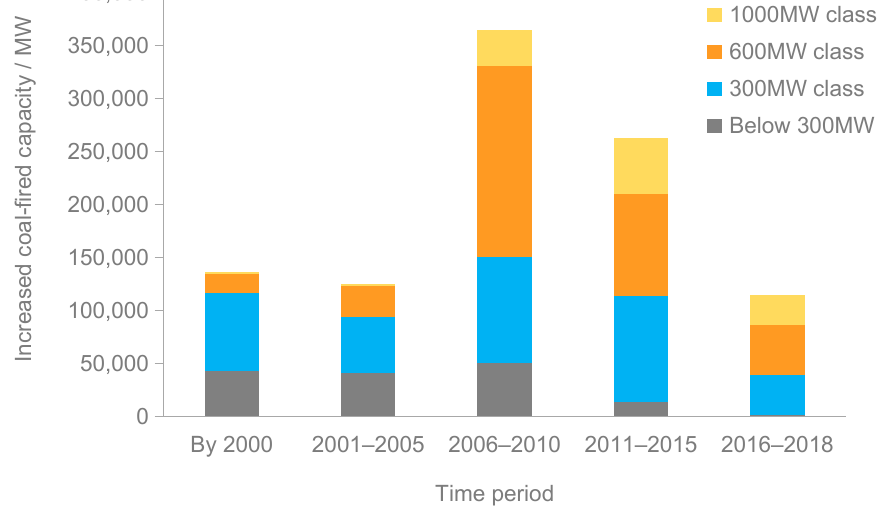
Figure 6. Increased coal-fired power capacity by the unit capacity (2018).